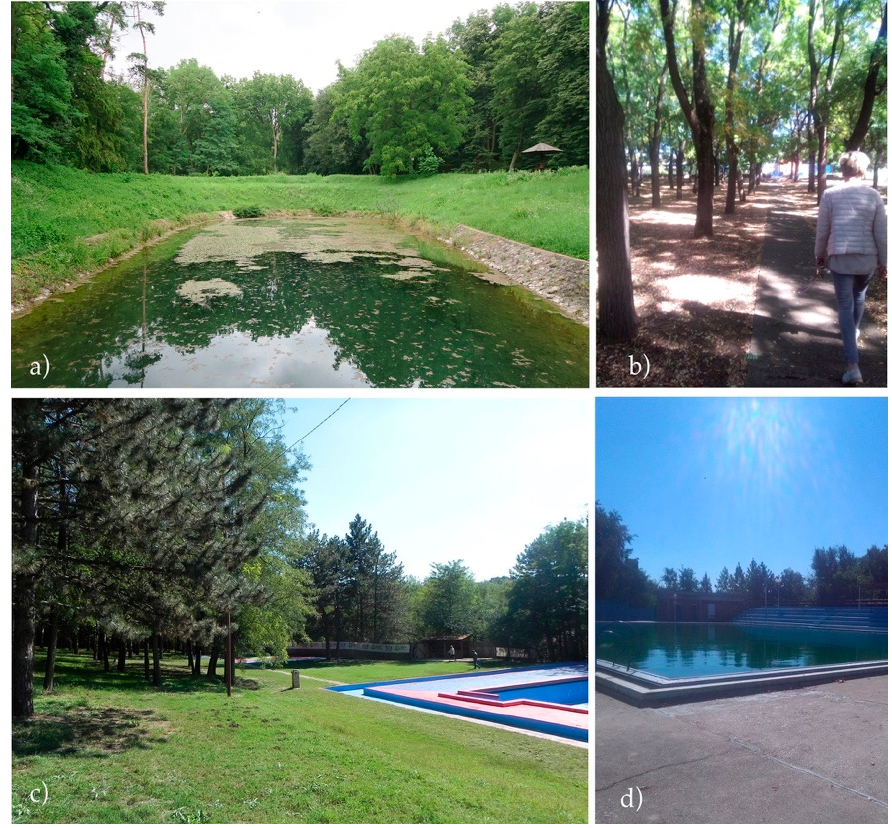
Figure 5. ( a ) Ljuba—currently an undeveloped site although used in Roman era; ( b ), Banatsko Ve- liko Selo—paths to outdoor pools ( c , d ) Banatsko Veliko Selo—outdoor swimming pool